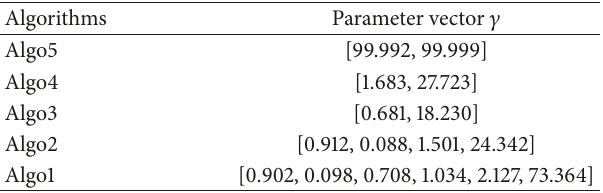
Table 2: Sensitive features parameters. Table 3: Results of parameter